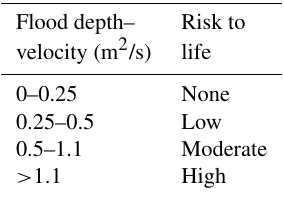
Table 4. Erosion risk as a function of the distance from the receptors to erosion magnitudes greater than 0.25m of bed level change. A distance of 7.5m corresponds to the expected retreat for the 10-year return period (Jiménez et al.,